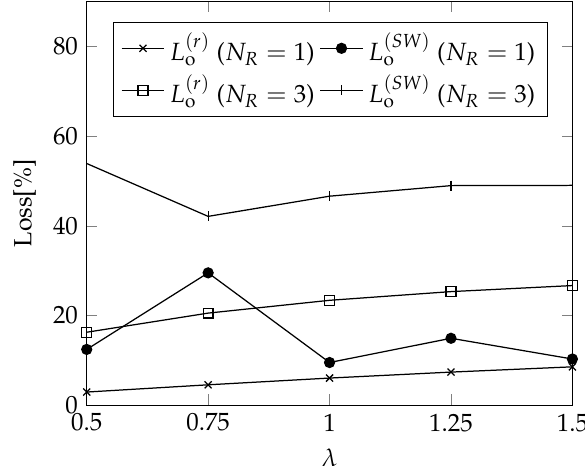
Figure 4. Impact of stickiness on MNOs’ profits.